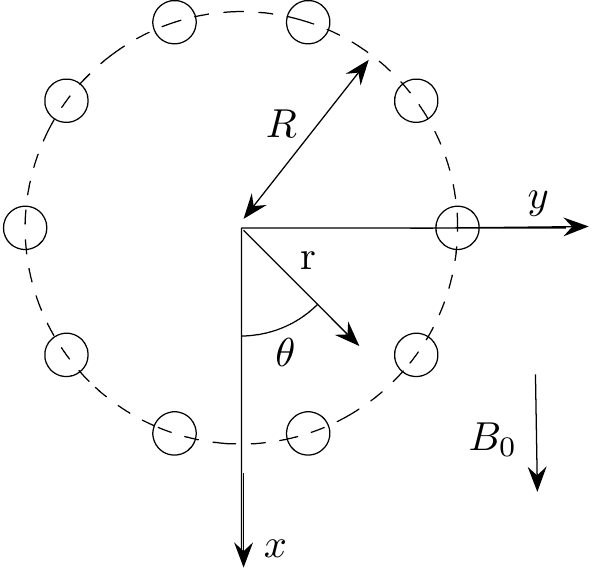
Fig. 1. Cylindrical configuration of tethers; θ will be called az- imuthal